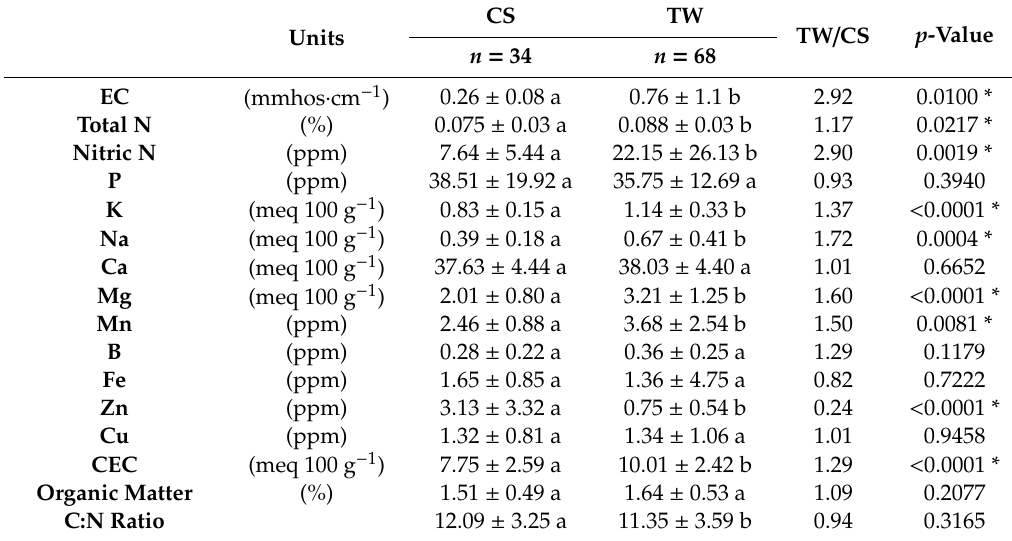
Table 6. Di ff erences between the control soils (CS) versus soils irrigated with treated wastewater